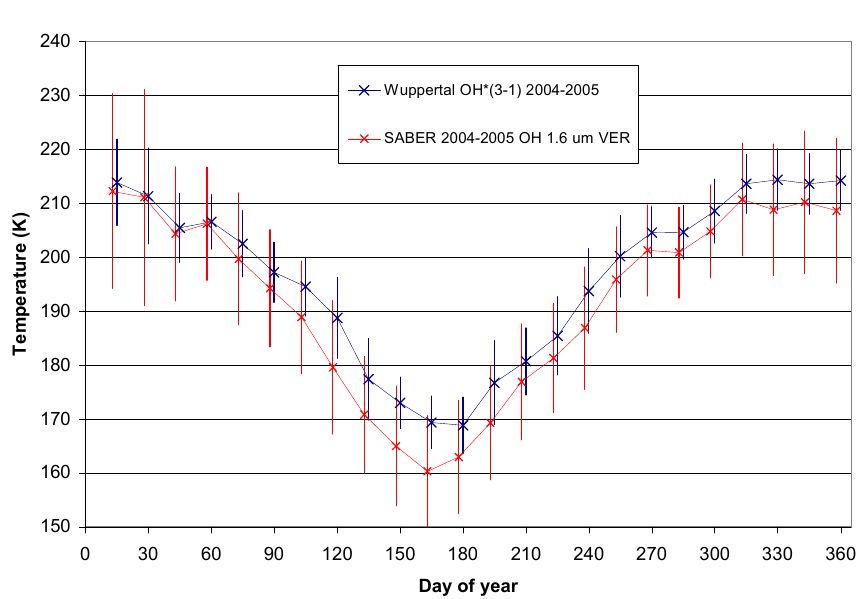
Fig. 13. OH*(3-1) rotational temperatures from Wuppertal in 2004 and 2005 together with OH-equivalent temperatures calculated from SABER temperature profiles at Wuppertal in 2004 and 2005 using the SABER OH 1.6 µ m VER profile as the weighting function. The SABER points have been offset by − 2 days on the x-axis to improve the clarity of the figure. The error bars are one standard deviation in all